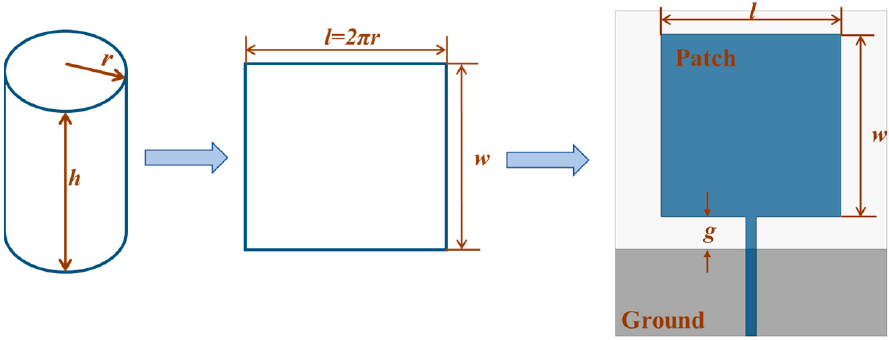
Figure 2. Rectangular patch planar monopole antenna estimated using the cylindrical approximation.